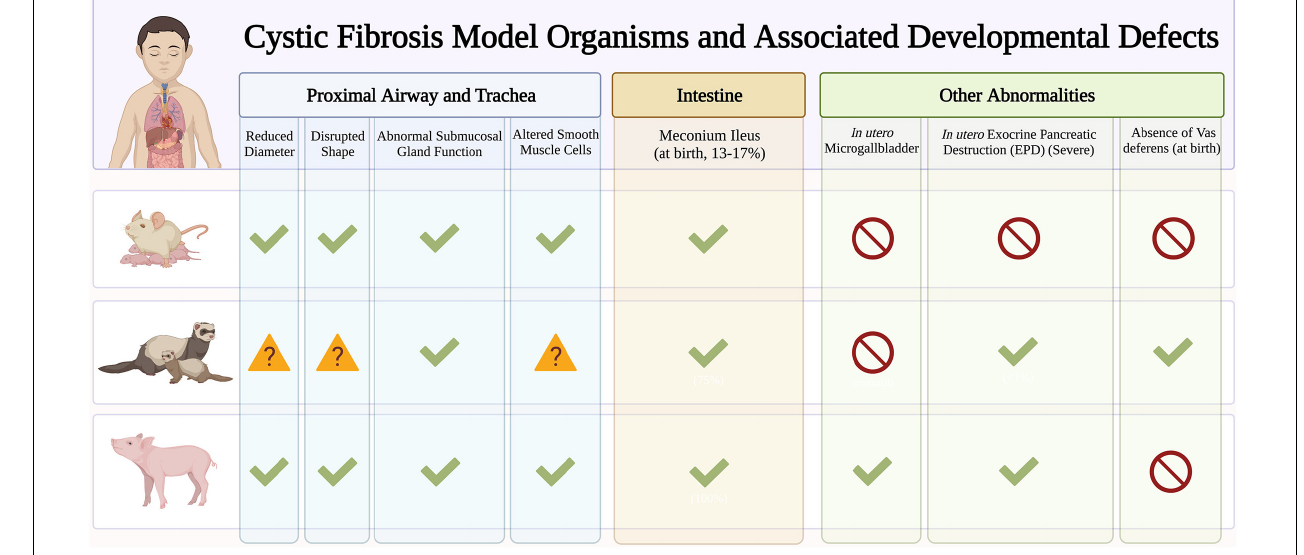
FIGURE 2 | Early developmental pathology in cystic fibrosis (CF) animal models. Early manifestations of CF disease are recapitulated in different CF animal models. Checkmarks indicate presence of symptoms. Absence of symptoms is indicated by the red circle symbol. The question mark symbols indicate further investigation